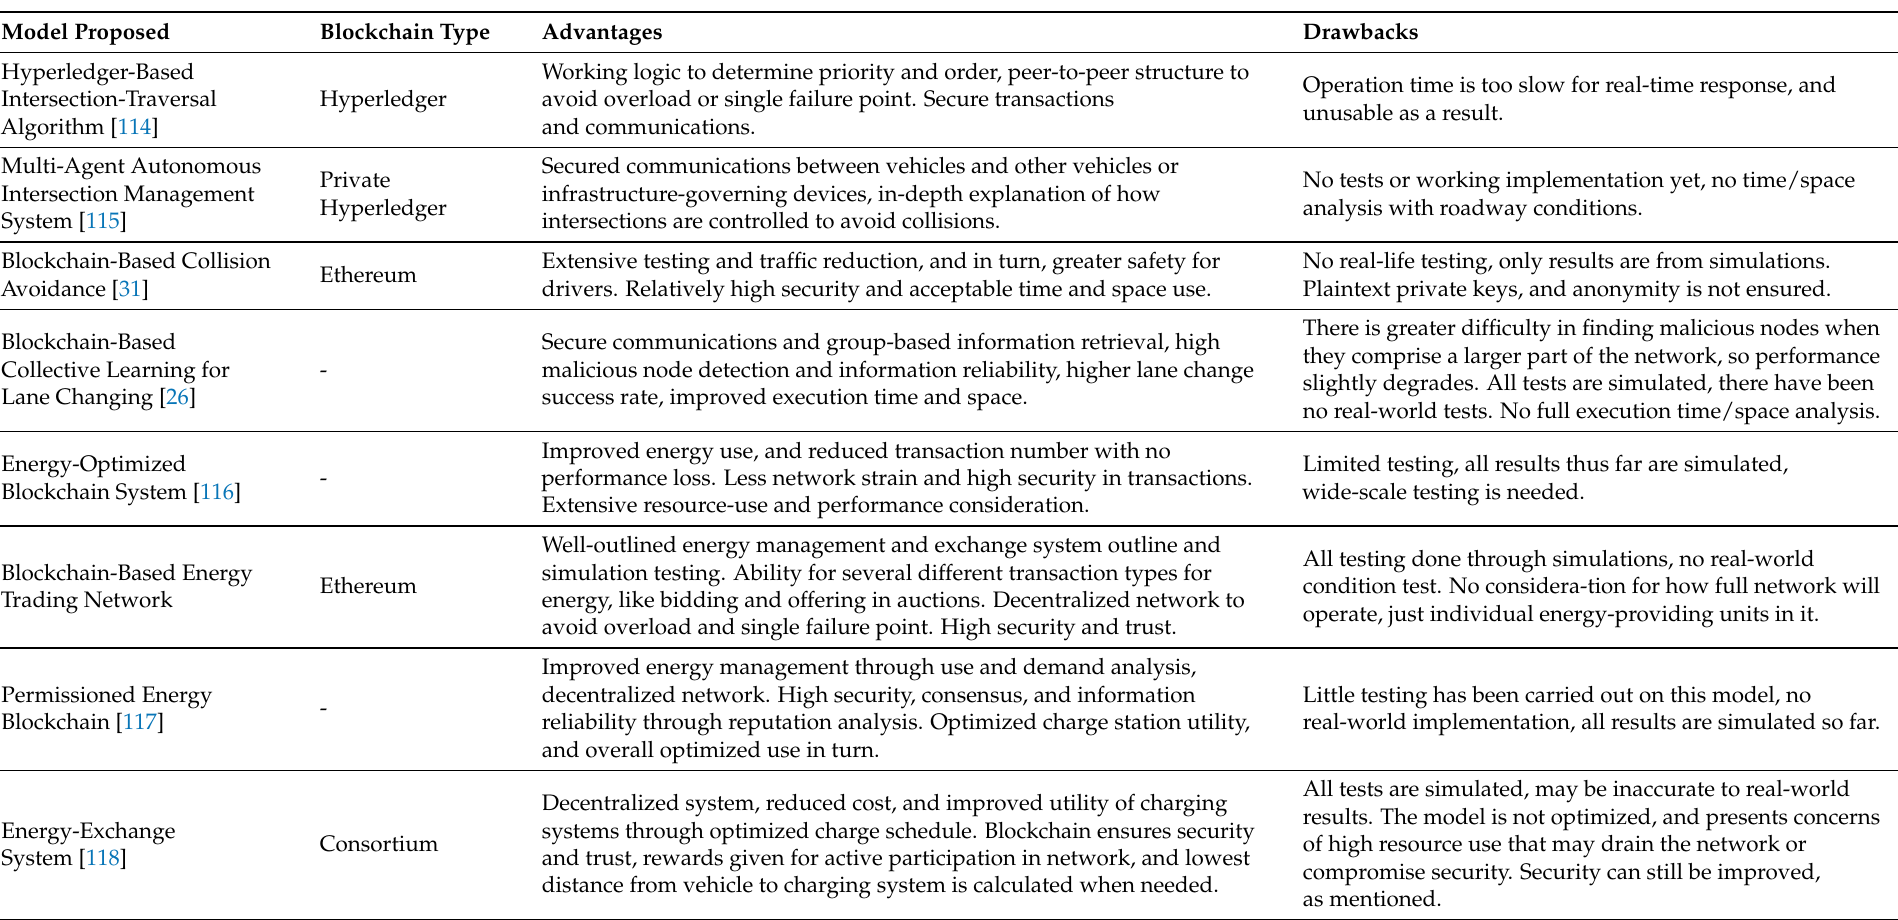
Table 6. A comparison of the selected previously discussed blockchain-based improvement and energy use outlines in terms of advantages, drawbacks, and type of blockchain used. Model